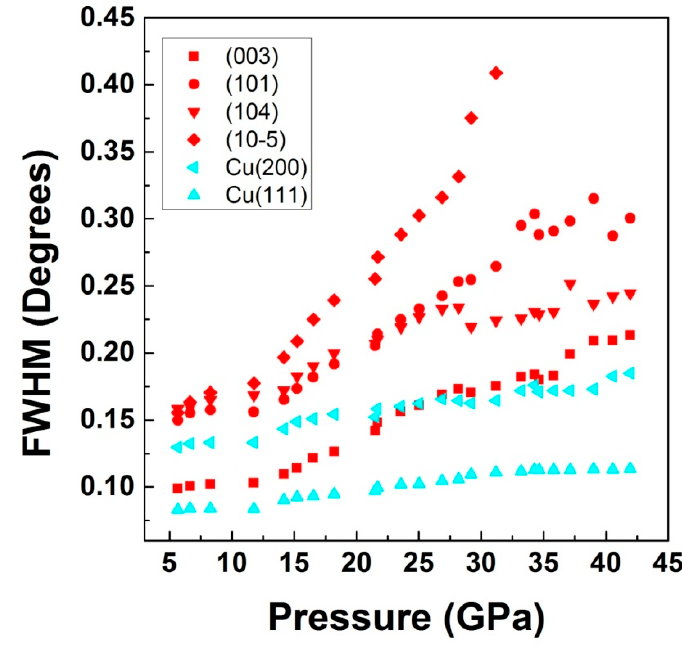
Figure 9. Full-width at half maxima (FWHM) of various diffraction peaks from the sample along with peaks from the pressure calibrant (Cu).